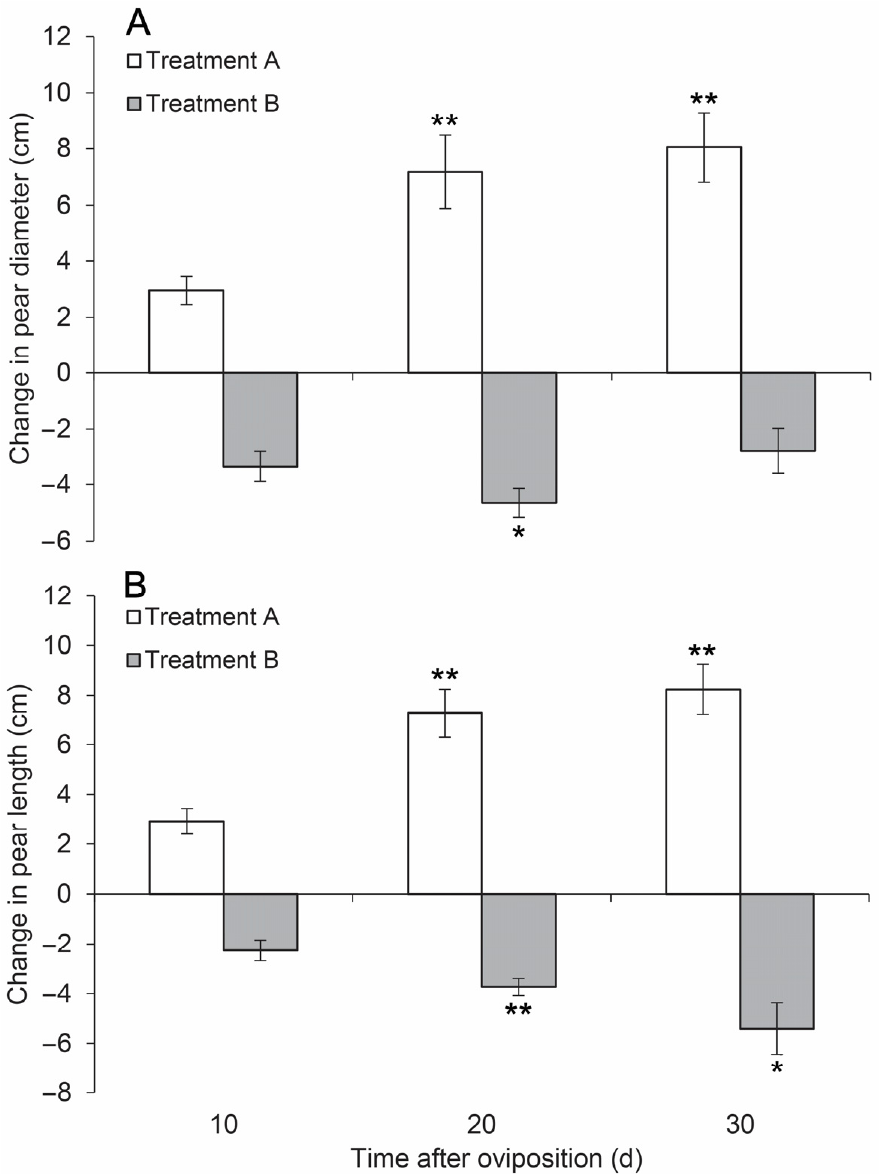
Figure 1. Changes in the diameter ( A ) and length ( B ) of pear fruits on 10, 20, and 30 d after oviposition by female R. foveipennis in 2013, Vertical bars are standard deviations; * statistical significance at 0.05 level, ** statistical significance at 0.01 level.